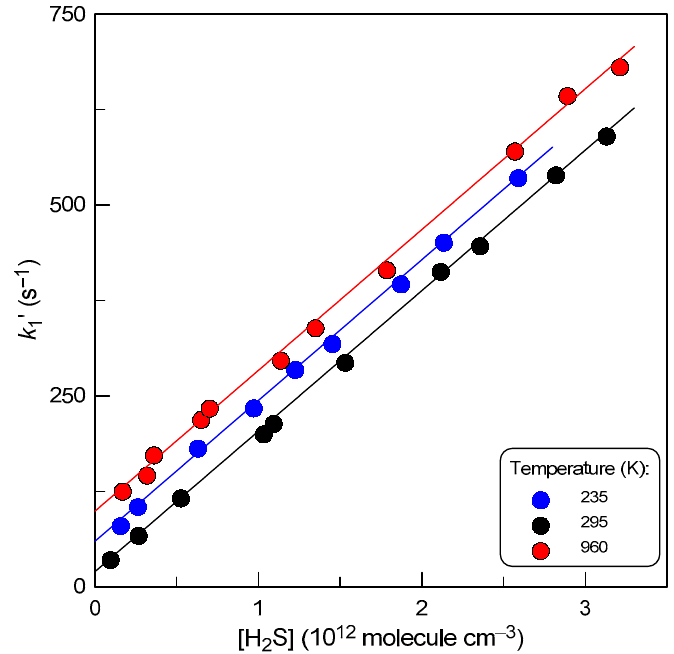
Figure 3. Dependence of the pseudo-first order rate constant, k 1 ′ = k 1 [H 2 S], on the concentration of H 2 S at different temperatures. For clarity, k 1 ′ data at T = 235 and 960 K are Y-shifted by 35 and 50 s − 1 , respectively.